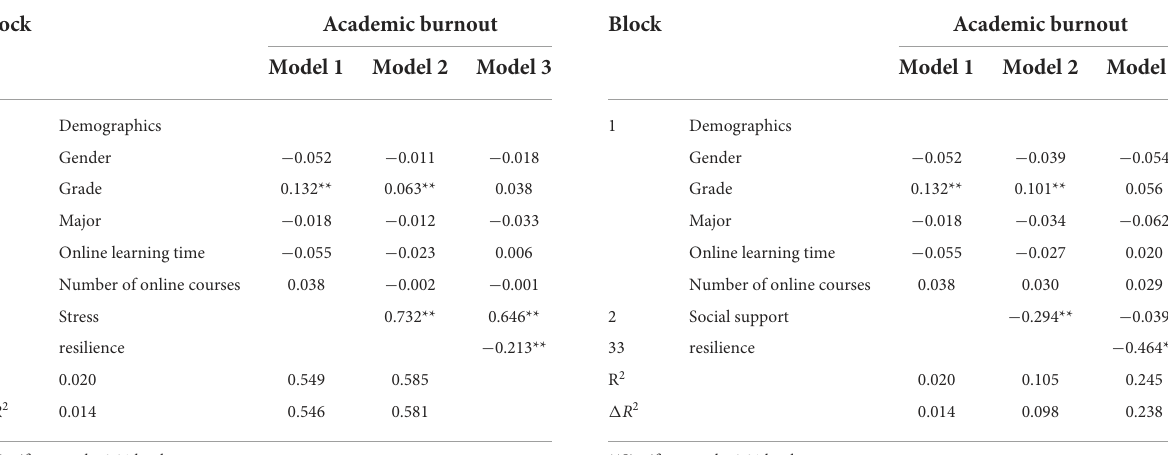
TABLE 6 Hierarchical linear regression analysis (stress as independent).